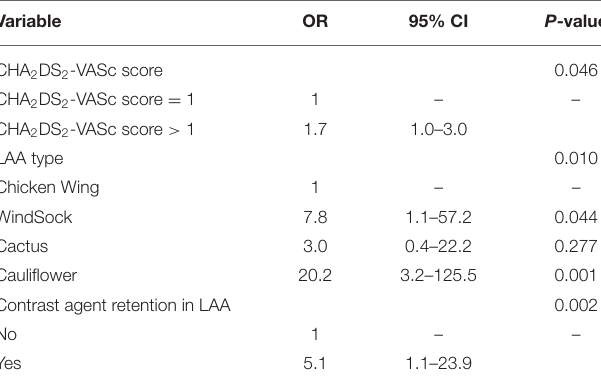
TABLE 3 | Multivariable logistic regression analysis of factors associated with cardioembolic stroke.